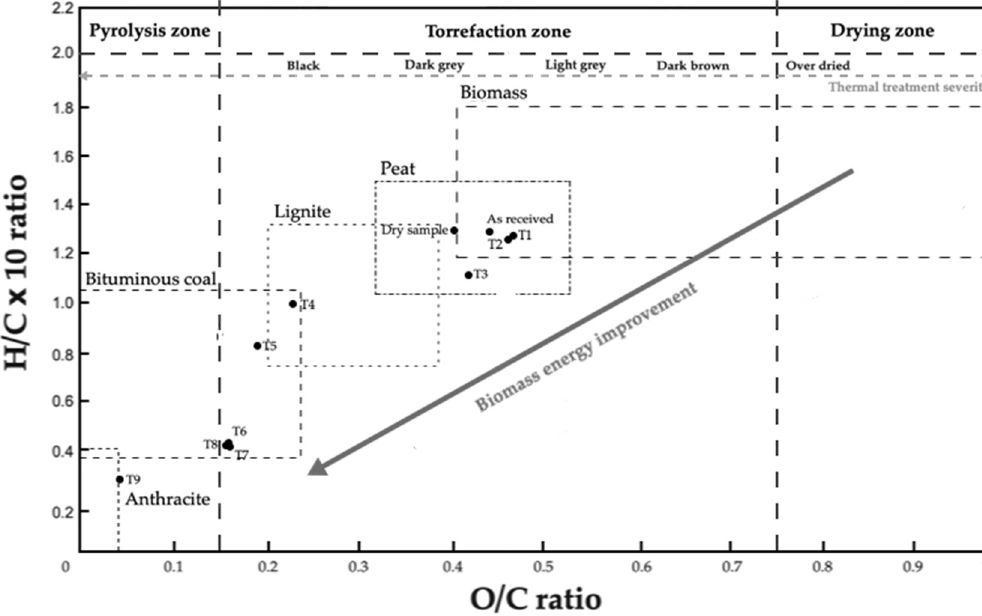
Figure 9. Graphical representation of van Krevelen diagram for natural, dry, and all torrefied samples of biomass (adapted from [34] ).